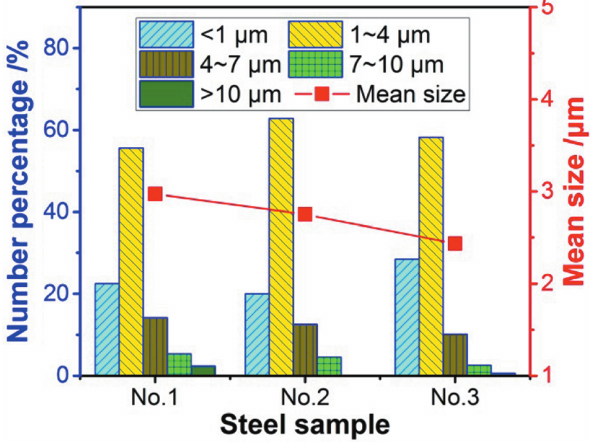
Figure 6: Inclusion size distribution of three